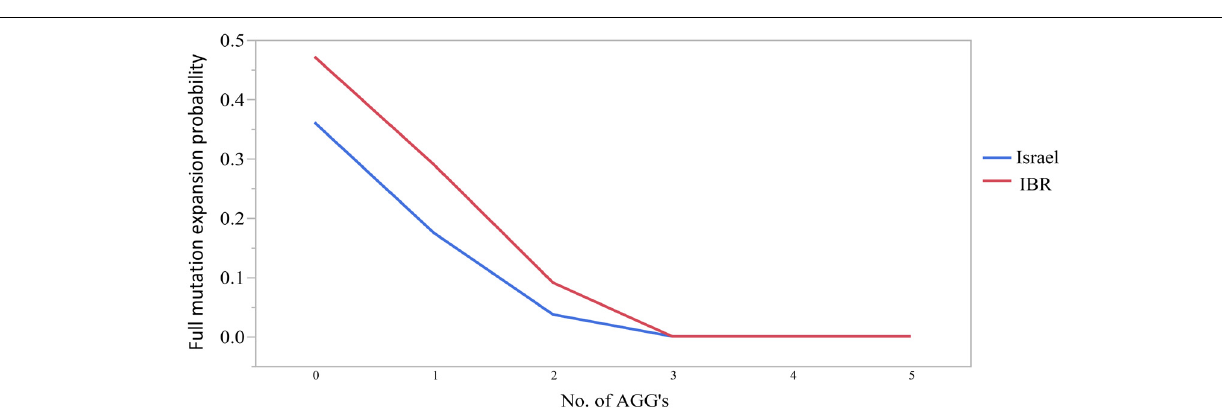
FIGURE 2 | The effect of the number of AGG interruptions upon the probability for a full mutation expansion.